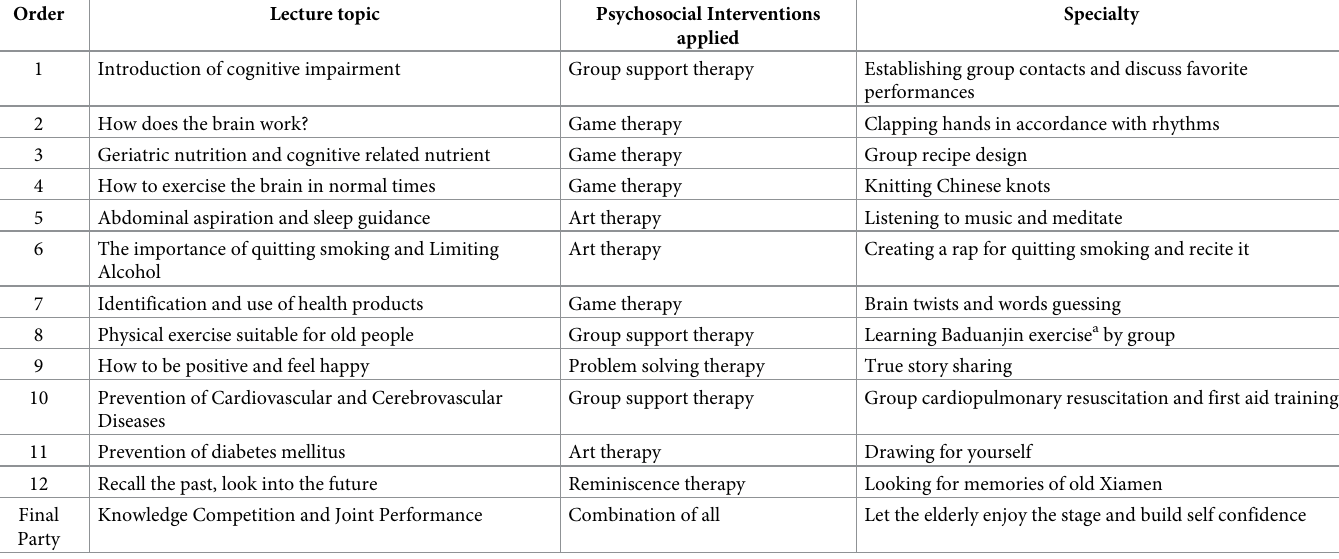
Table 1. Curriculum of cognitive health education combined with psychosocial interventions.